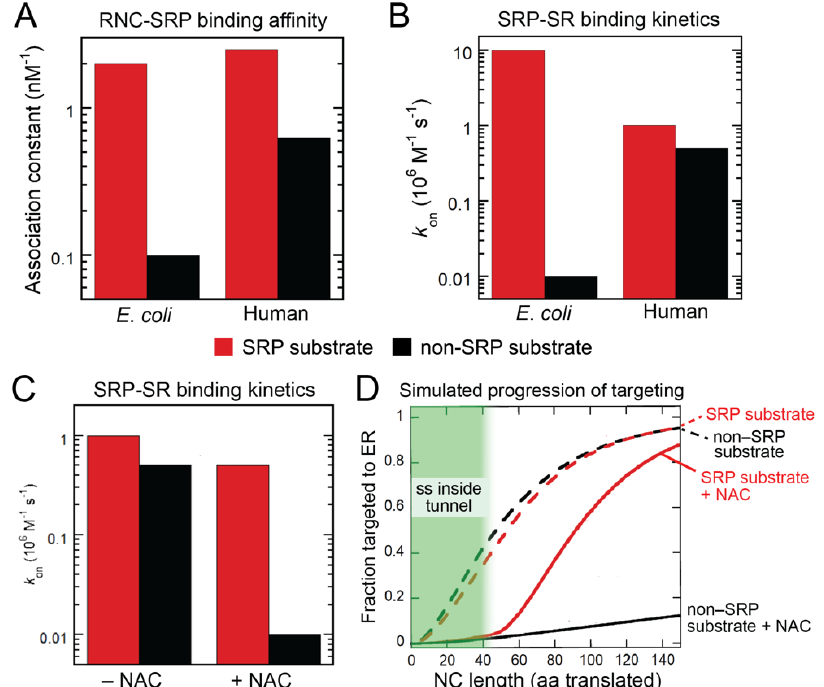
Figure 3 . NAC regulates the activity of mammalian SRP to help reject signal-less ribosomes from ER targeting. Comparison of the specificity during the cargo recognition ( A ) and targeting steps ( B ) between the E. coli and human SRPs. The rate and equilibrium constants were measured with purified RNC, SRP and SR in vitro and show the promiscuity of human SRP in both steps. Adapted with modifications from the data in [56,57]. ( C ) NAC enhances the specificity of human SRP during the SR recruitment step from <2-fold to ~50-fold. Adapted from [56]. ( D ) Simulation of the progression of cotranslational protein targeting to the ER with and without NAC present. The simulation is based on a kinetic model of SRP-dependent protein targeting using experimentally determined rate and equilibrium constants of the cargo binding and SRP–SR assembly steps, followed by a commitment step in which the RNC-SRP–SR complex loads the translating ribosome onto Sec61p. The enhanced selectivity of ER targeting in the presence of NAC arise from two effects: suppression of pre-mature targeting before a signal sequence emerges from the ribosome, and inhibition of non-specific SRP–SR association on ribosomes that do not expose an ER targeting signal. Adapted from [56].